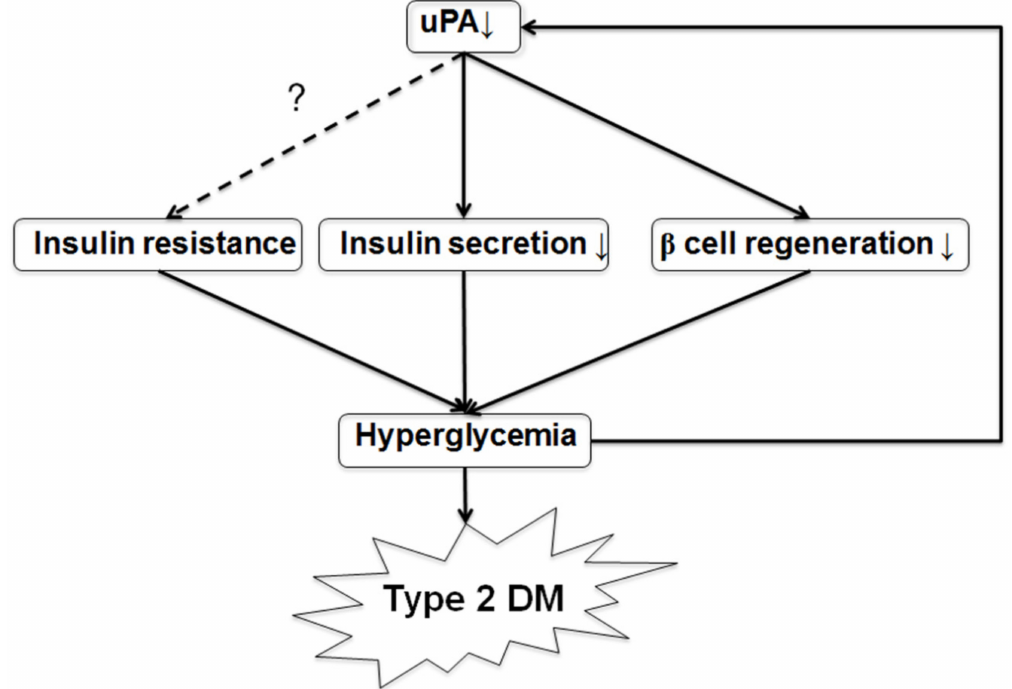
Figure 7. A model of uPA deficiency leading to development of T2DM. According to our results,